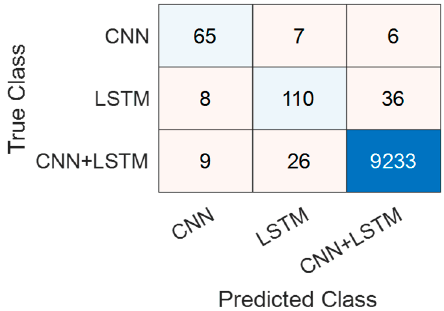
Figure 22. Confusion matrix comparing the methods used.